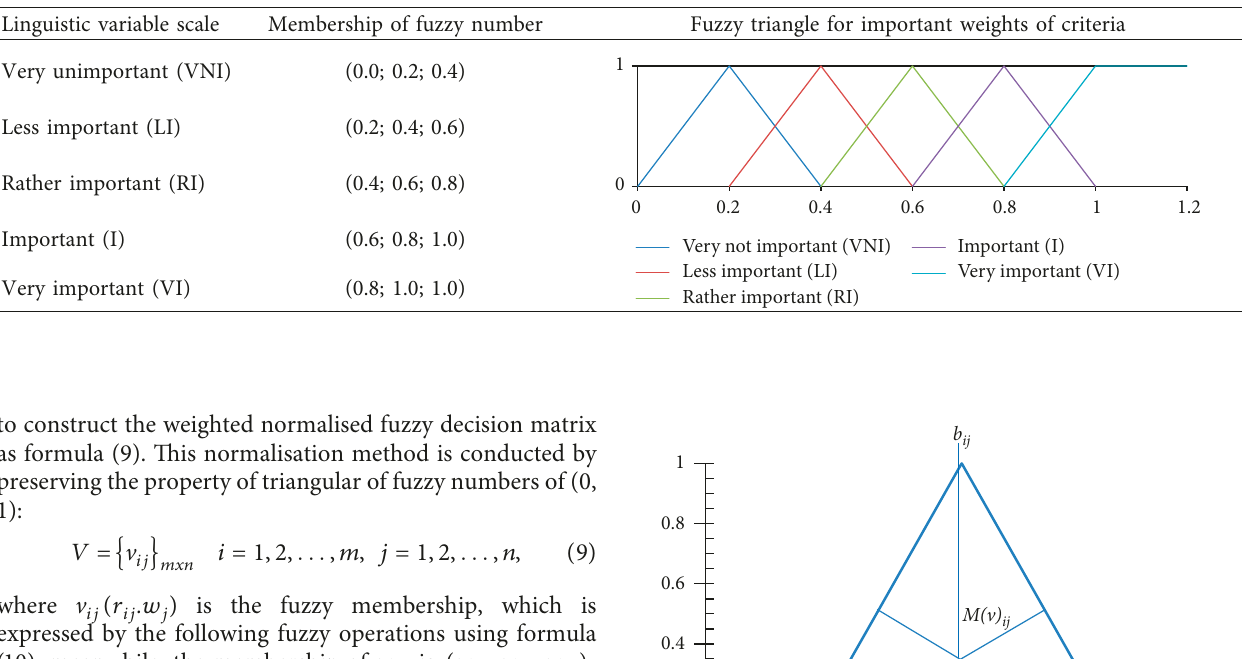
Table 2: Linguistic for important criteria weights.